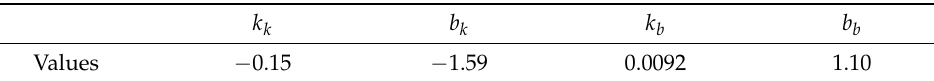
Figure 12. Fitting results for ( a ) k ; ( b ) b . Table 12. Values for the coefficients of k k , b k , k b , and b b